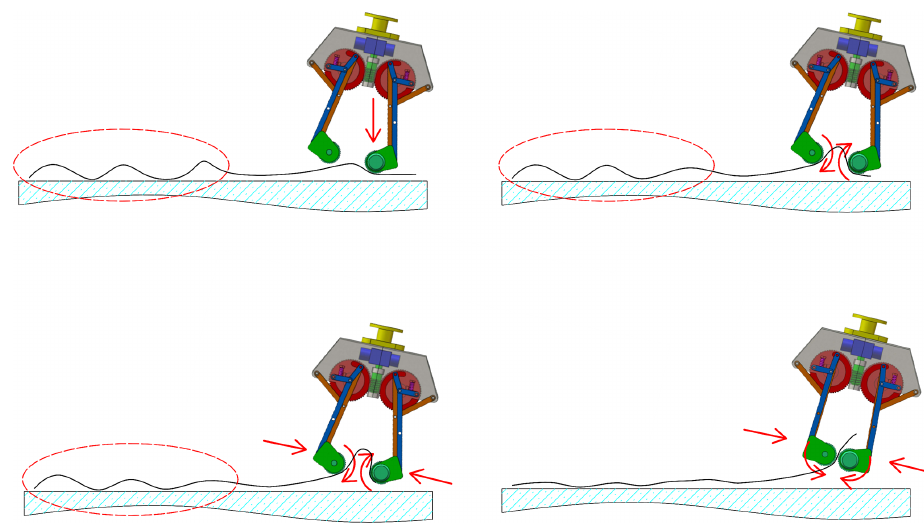
Figure 10. Diagram of corner grabbing-and-spreading process.